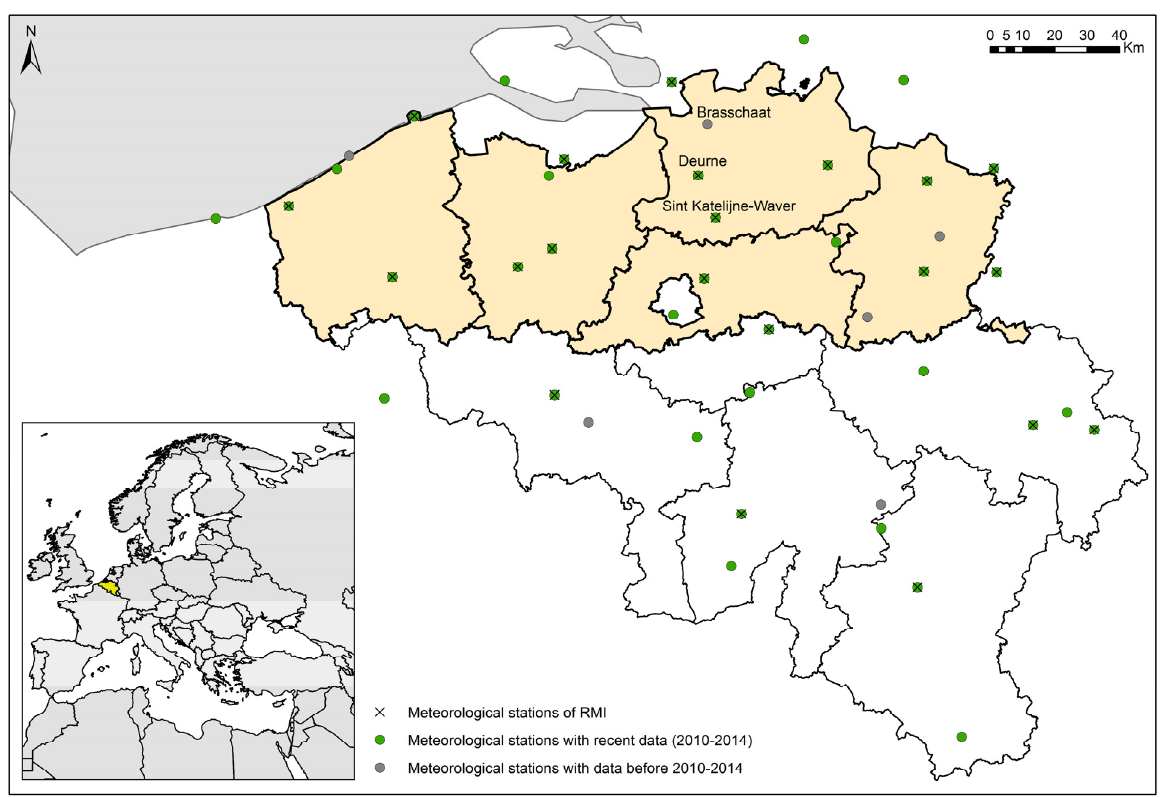
Figure 2. Location of the measurement stations